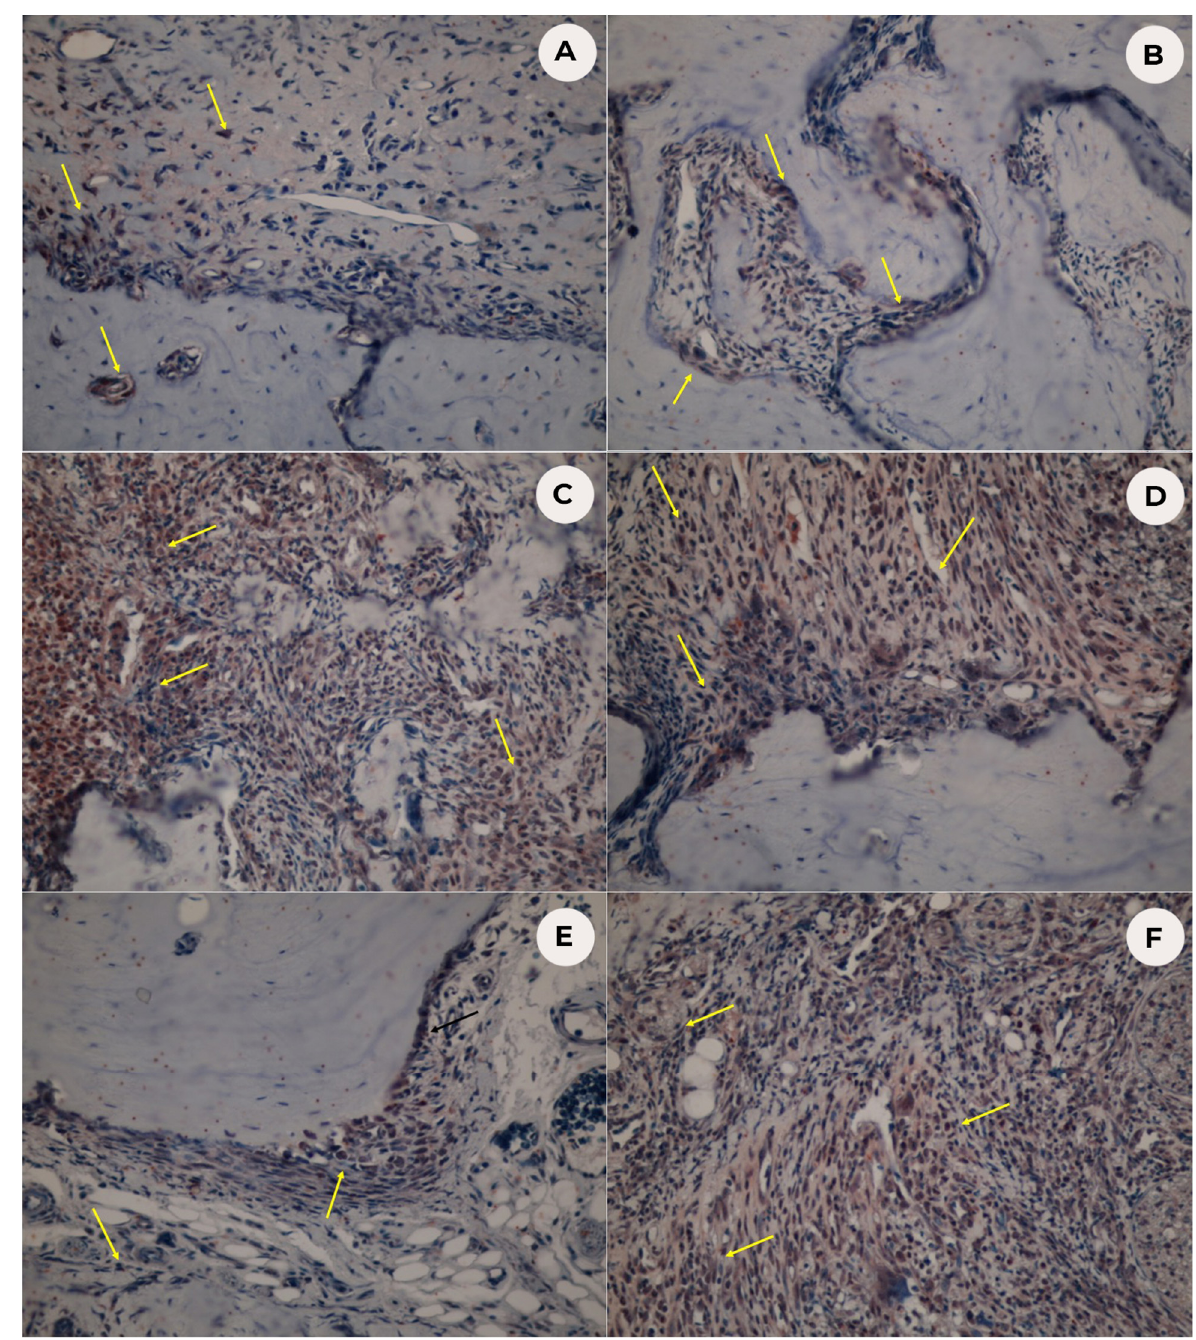
Figure 2. Representative histological images of HIF-1 α immunohistochemical staining of control and experimental groups ( A ) Group I (Control): a few positive cells were shown (arrows). ( B ) Group II (GS): positive cells were shown around the bone trabecula (arrows). ( C ) Group III (GS/DFO): diffuse positivity was observed (arrows). ( D ) Group IV (ZA): positive cells were seen in both bone periphery and connective tissue (arrows). ( E ) Group V (ZA-GS): focal positive cells were determined (arrows). ( F ) Group VI (ZA-GS/DFO): positive cells were observed in large areas (ar- rows). (HIF-1 α , Original magnification ×400).